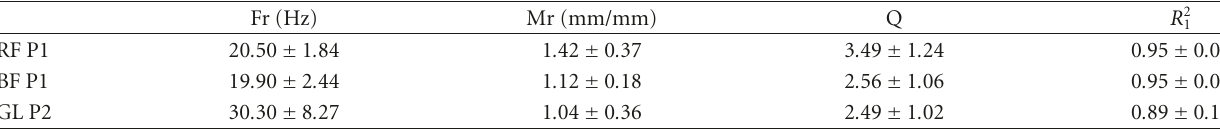
Figure 9: An example of estimated normalised resultant muscle displacements over frequency with respect to position P1 ((a) for Rectus Femoris, (c) for Biceps Femoris, (e) for Gastrocnemius Lateralis) and P2 ((b) for Rectus Femoris, (d) for Biceps Femoris, (f) for Gastrocnemius Lateralis). Table 1: Frequency response parameters: mean ±